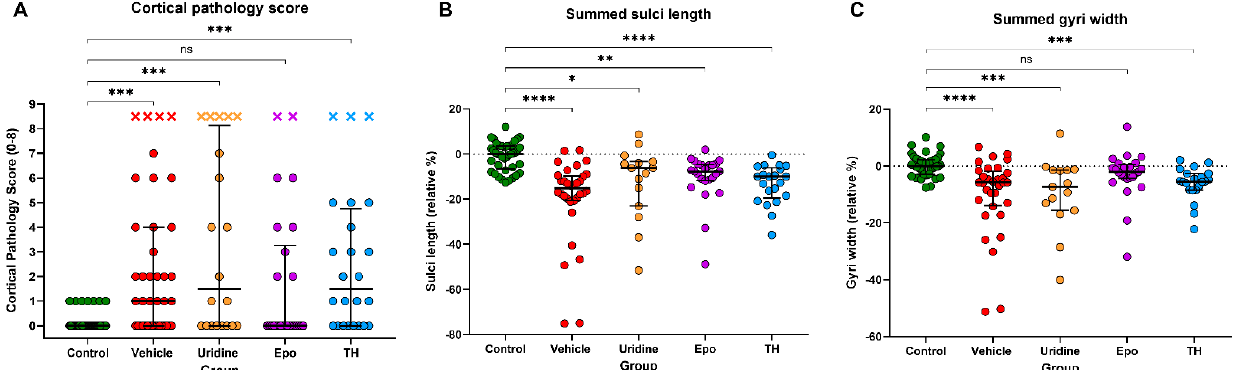
Figure 3. Cortical Pathology and Morphology. The median and IQR is plotted on each graph. ( A ) Surviving animals received combined scores of 0–8 (0–4 cortical pathology + 0–4 mineralization) while animals that died after the HIH insult received a score of 8.5. Control animals had a median cortical pathology score of 0 with no deaths. Median scores significantly increased in the Veh group to 1 and in the Ur and TH groups to 1.5. Deaths also increased in the Veh, Ur, and TH groups to 4, 5, and 3, respectively. Compared to controls, number of deaths in the Epo group increased to 2. ( B ) Summed sulci length in the HIH groups relative to the control group. After calculating the sum of the lengths of each sulci, the HIH groups all displayed a shorter sum of sulcal length than the control group. On average, HIH brains sulci were 8.8% (3.3–16.9%) shorter than control brains. ( C ) Summed gyri widths in the HIH–exposed groups relative to control median. Similar to the summing of sulci, the summing of the width of each gyri showed that control brains had significantly wider gyri than Veh (3.6%; 0.1–9.5%), Ur (7.3%; 1.4–15.6%) and TH (5.4%; 2.6–8.4%) brains. Epo brains exhibited summed gyral widths more similar to control brains. * Denotes p –value < 0.05, ** denotes p –value < 0.01, *** denotes p –value < 0.001, **** denotes p –value < 0.0001, and ns denotes no significant difference.